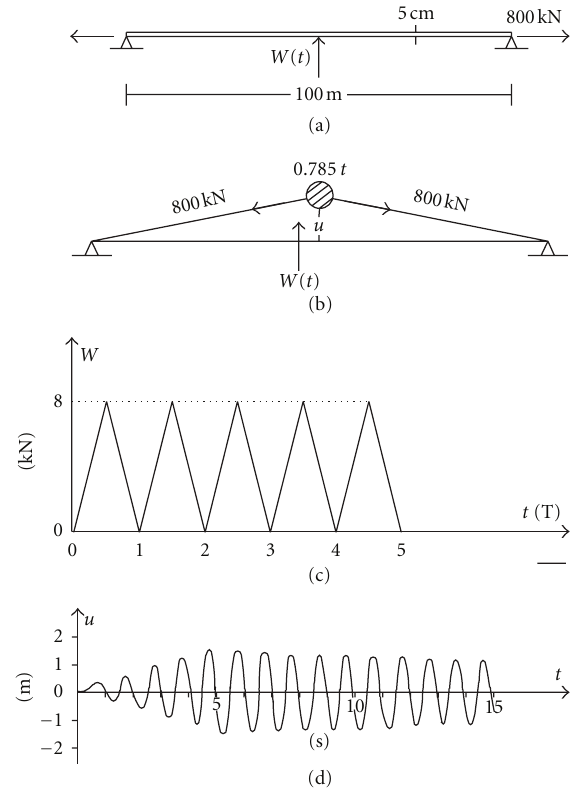
Figure 6: Fourth application: isolated cable subject to wind. (a) Given geometry and loading. (b) Parameters of dynamic analysis. history of displacement of center of